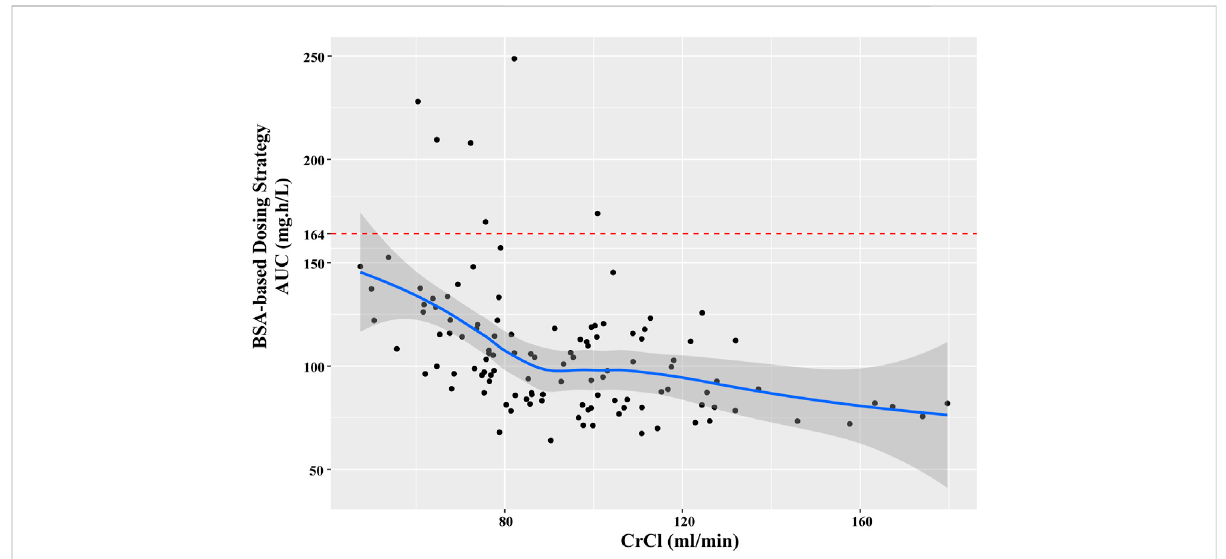
FIGURE 5 The relationship between estimated AUC and CrCl in current patients with BSA-based dosing